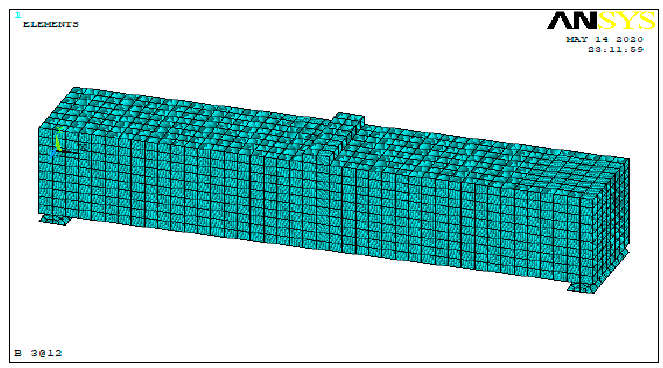
Figure 6. Typical idealization of the volume .